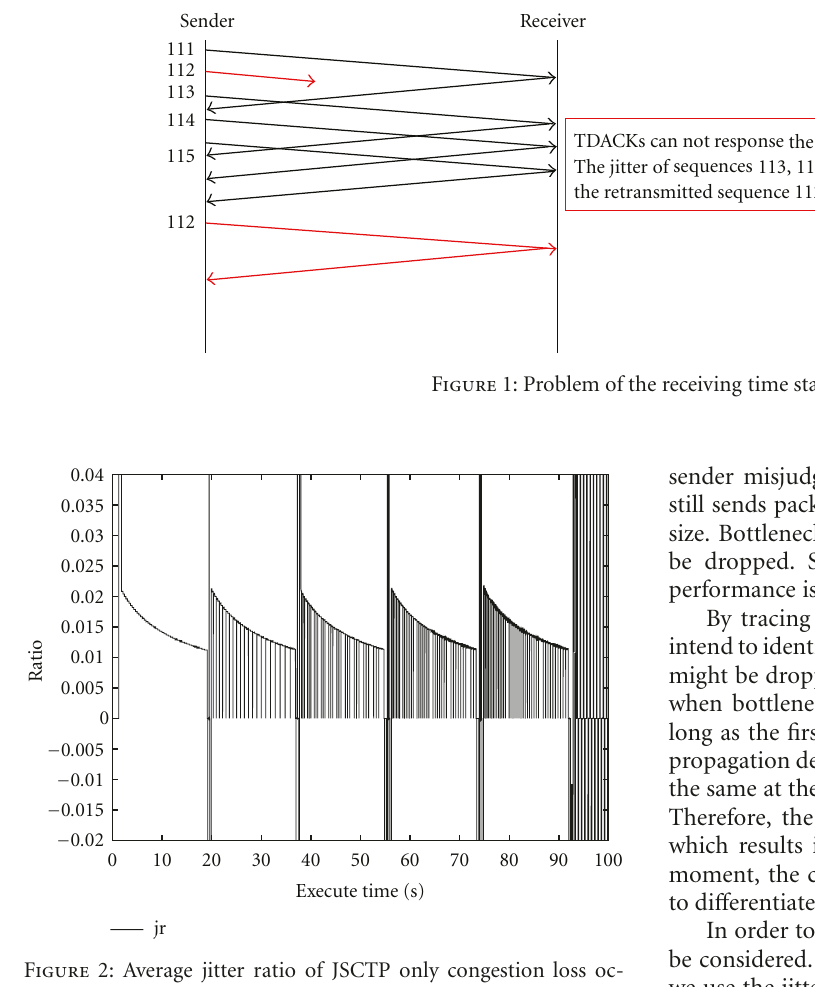
Figure 2: Average jitter ratio of JSCTP only congestion loss oc-